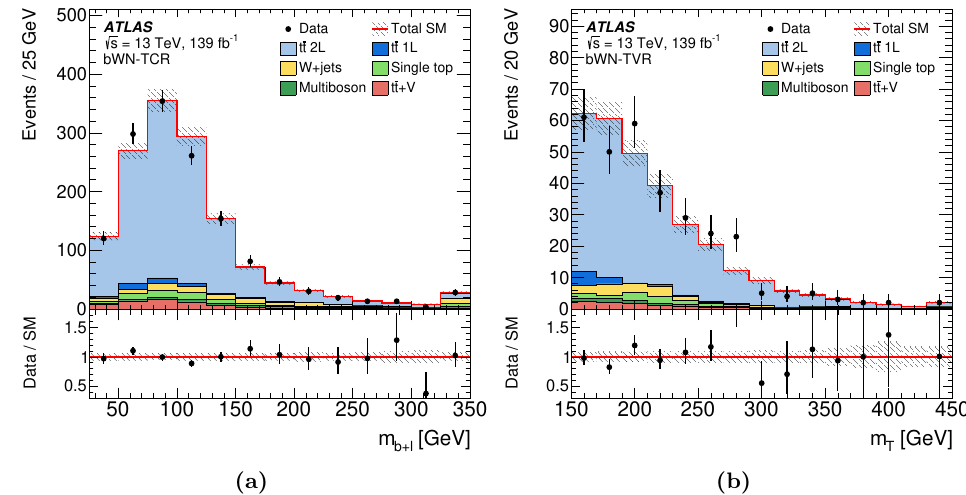
Figure 7. Selected distributions in the bWN CR and VR: (a) m b+ ‘ in the TCR, (b) m T in the TVR. The distributions shown are post-fit, i.e. each background is scaled by a normalisation factor obtained from a background-only likelihood fit to the CRs (see table 14). The hatched area around the total SM prediction and the hatched band in the Data/SM ratio include all statistical and systematic uncertainties. The last (first) bin contains overflows